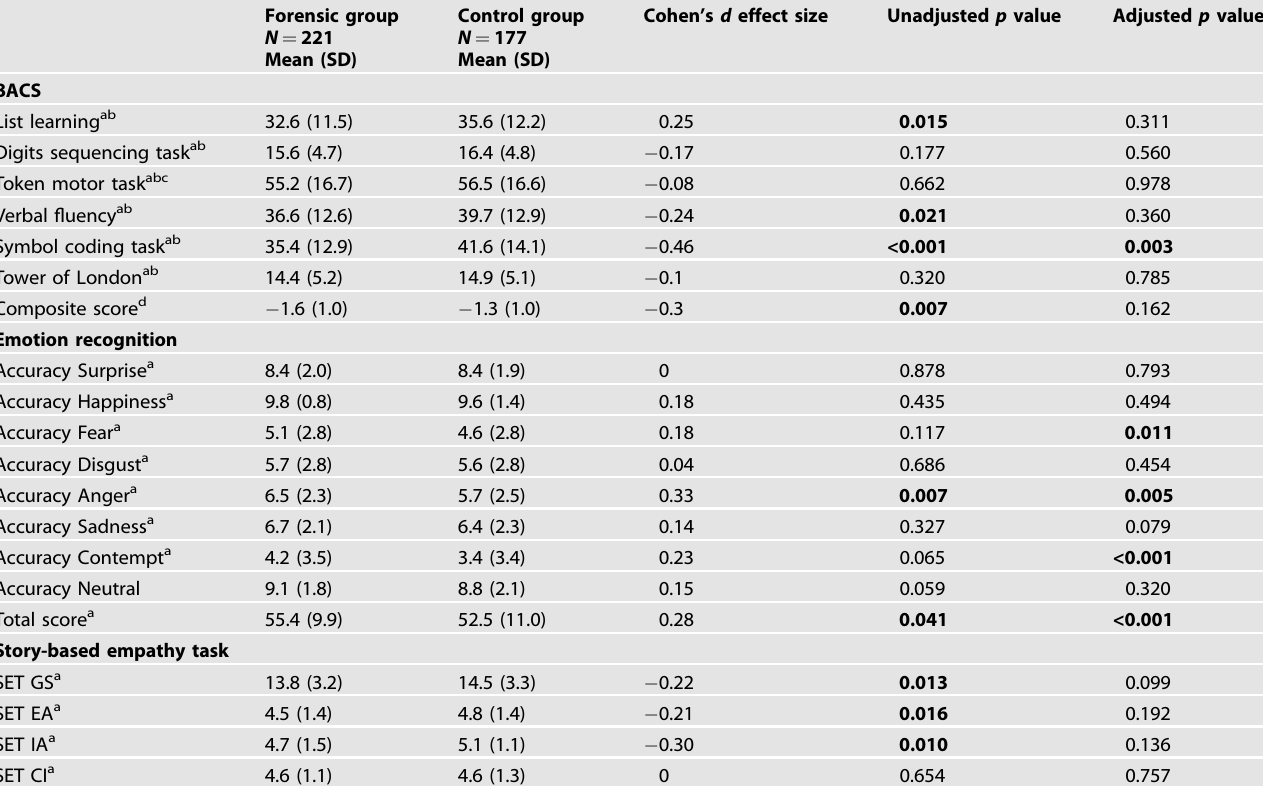
Table 2. Descriptive statistics of neurocognitive and social cognition tasks for forensic patients and